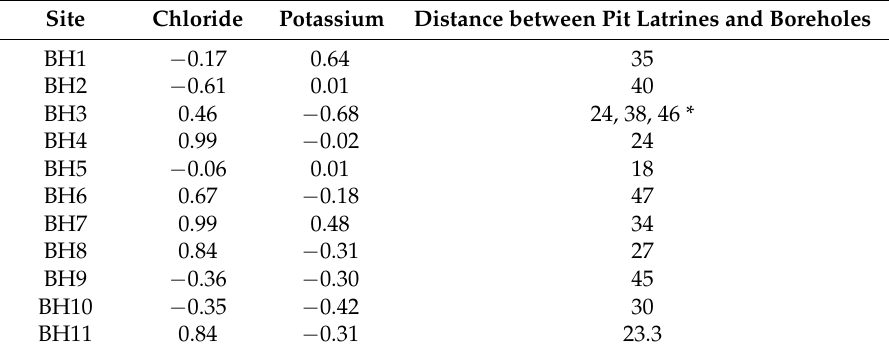
Table 5. Correlation of nitrate with chloride and potassium.